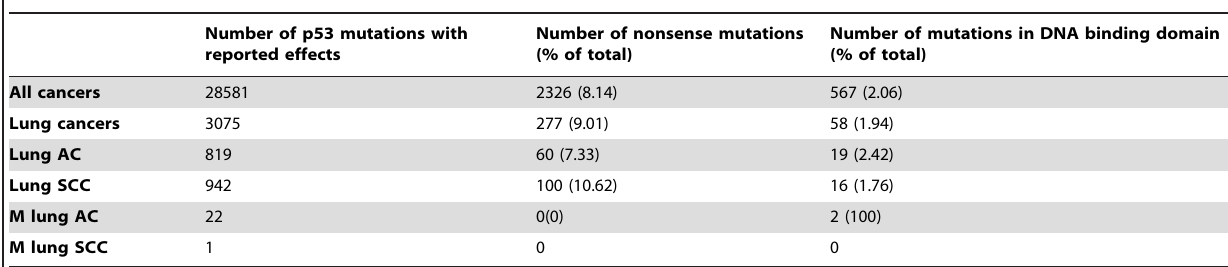
Table 1. p53 mutations in cancer.